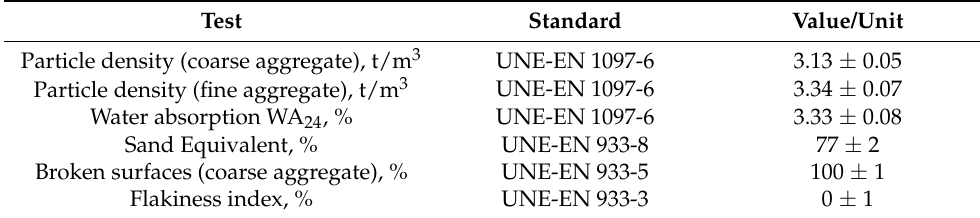
Table 3. Physical properties of electric arc furnace slags.